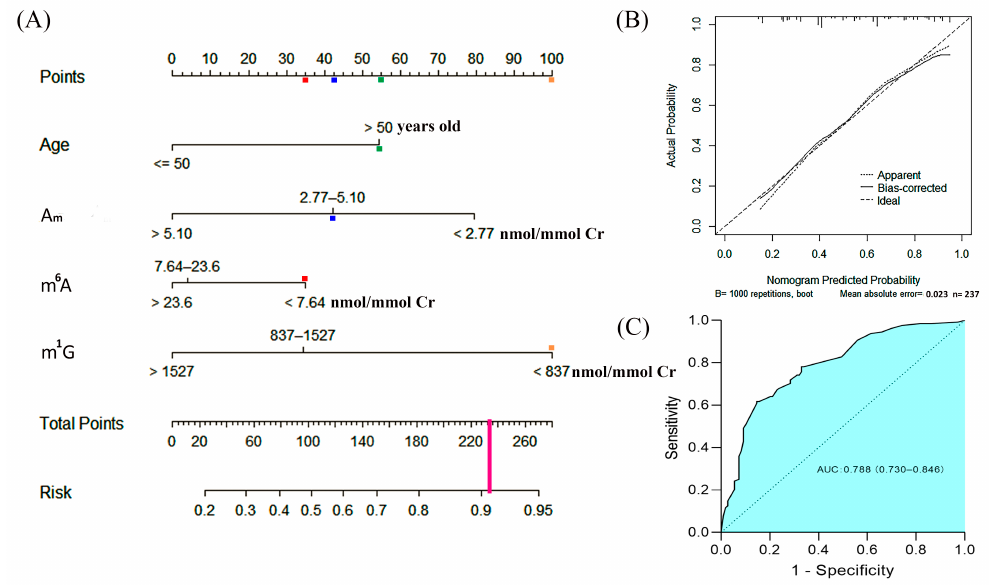
Figure 5. Construction of a predictive nomogram for the detection of early-stage breast cancer. ( A ) A nomogram for predicting the probability of the occurrence of early-stage breast cancer (EBC); ( B ) calibration plot. The reference line represents perfect equality of the predicted probability and the actual incidence of EBC, and ( C ) Receiver operating characteristics (ROC) curve of the multivariate logistic regression model. AUC: area under curve.